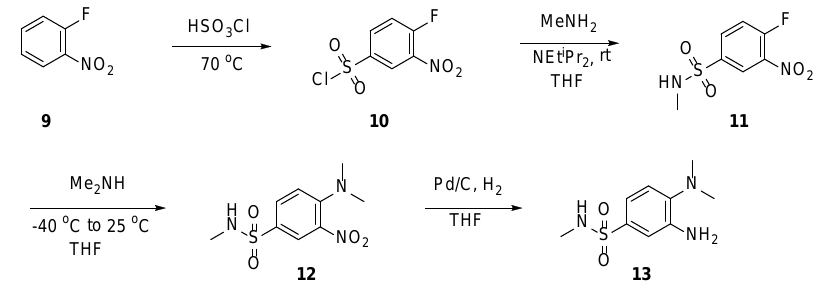
Scheme 1. Synthetic route to access non-commercial aniline 13 .